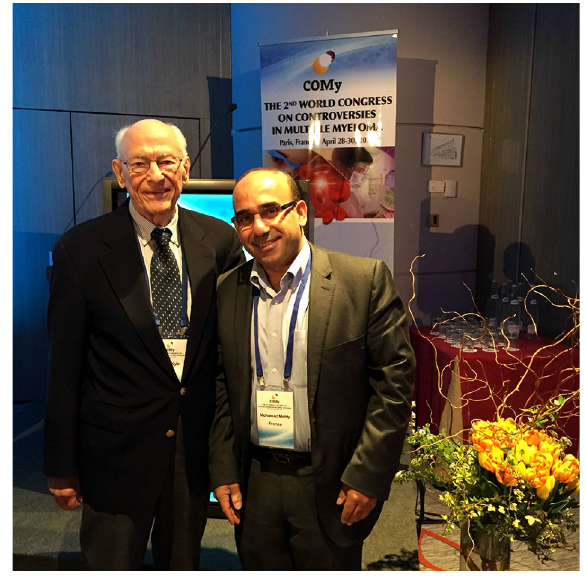
Fig. 1 Professor Kyle and Professor Mohty in 2016 at the 2nd Inter- national Congress for Controversies in Multiple Myeloma (COMy